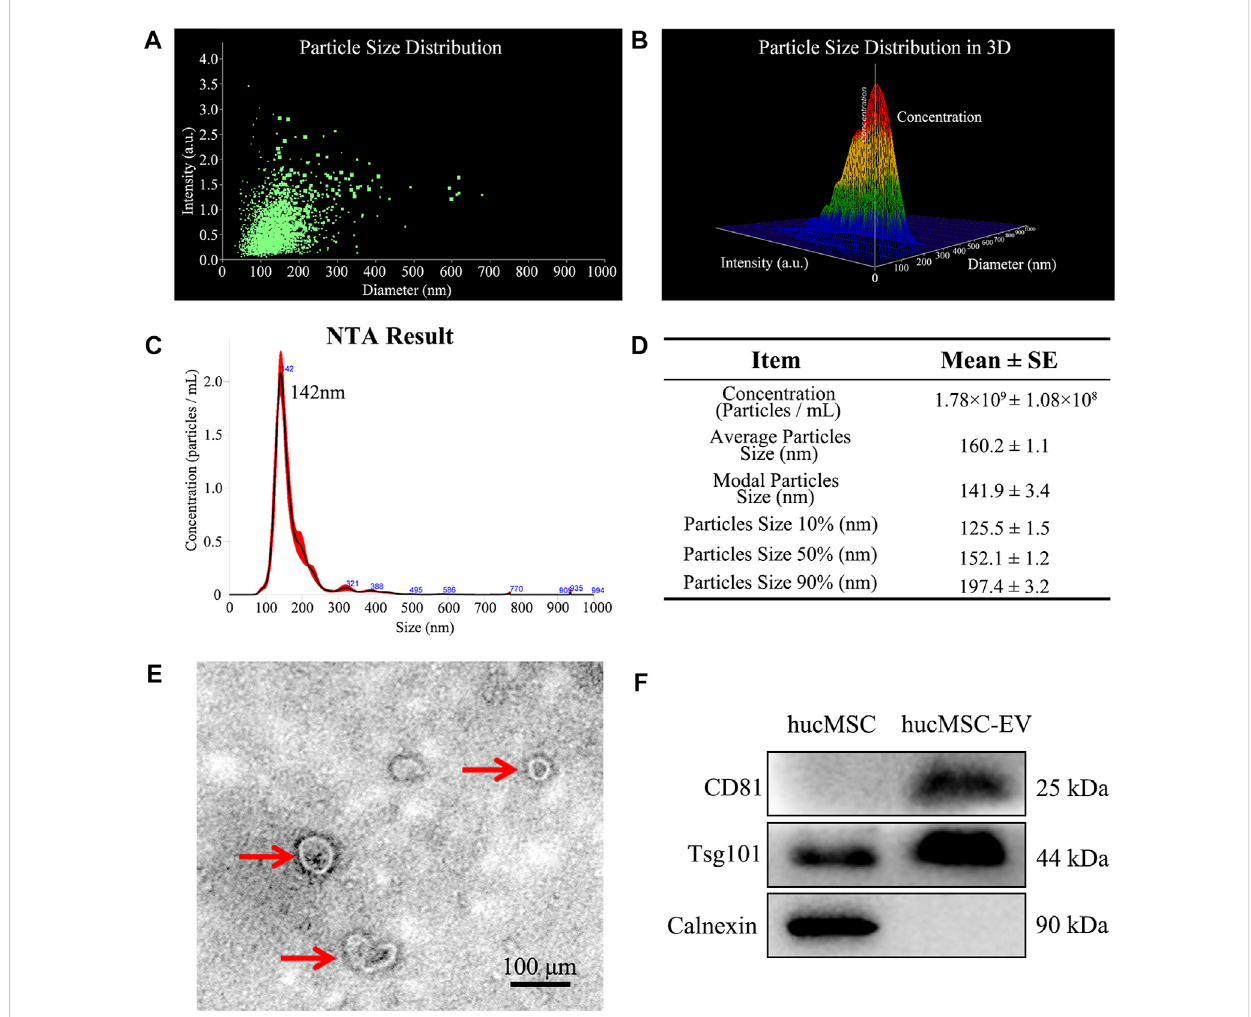
FIGURE 2 Identi fi cation of hucMSC-EV. (A, B) Size distribution and schematic illustration ofhucMSC-EV measured from NanoSight. (C) NanoSight measure of the particle diameter of hucMSC-EV. (D) A table for particle concentration, average particle size and modal particle size. (E) Transmission electron micrographs of hucMSC-EV. (F) Western blotting identi fi ed the positive exosome protein markers CD81 and Tsg101 and negative exosome protein marker